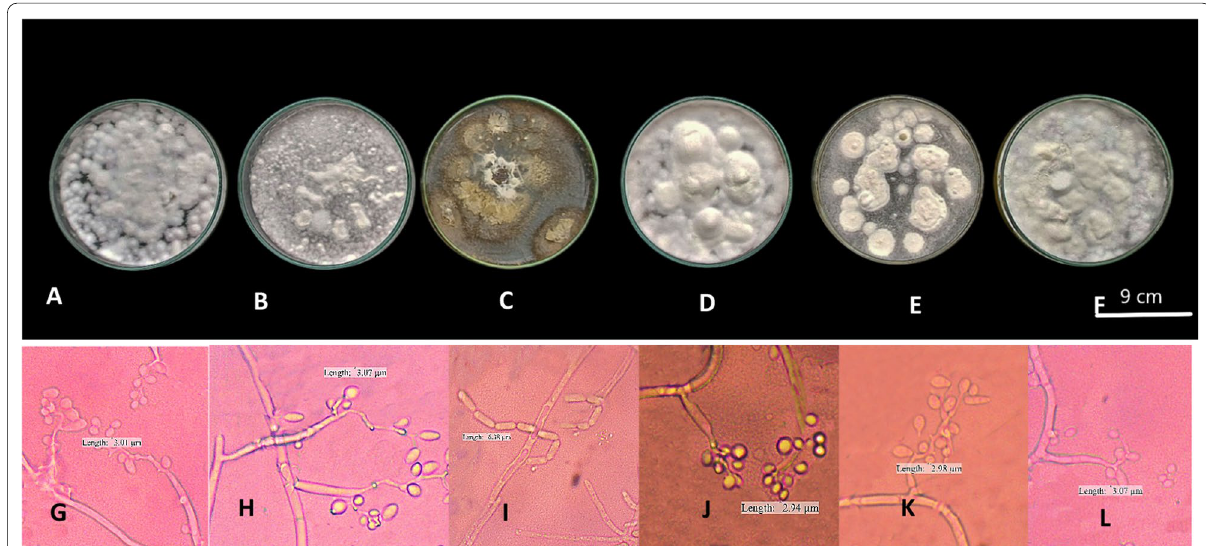
Fig. 1 Colony morphology of endophytic fungi cultured on PDA media (above) and the conidial and hyphal morphology (below) of the fungi: Beauveria bassiana of JGTP240521 isolate ( A and G ) and WTTJC260521A isolate ( B and H ), Metarhizium anisopliae WTTJC260521B isolate ( C and I ), Beauveria bassiana of WTTJC290521A isolate ( D and J ), WTTJC290521B isolate ( E and K ), and JGNT300521 isolate (F and